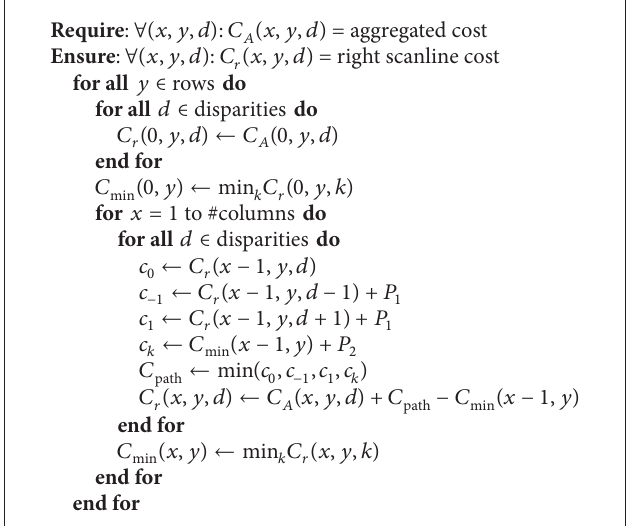
Algorithm 2: Scanline optimization step in left to right orientation (denoted as ScanRight ). Note: for all : loops are independent; for : loops are